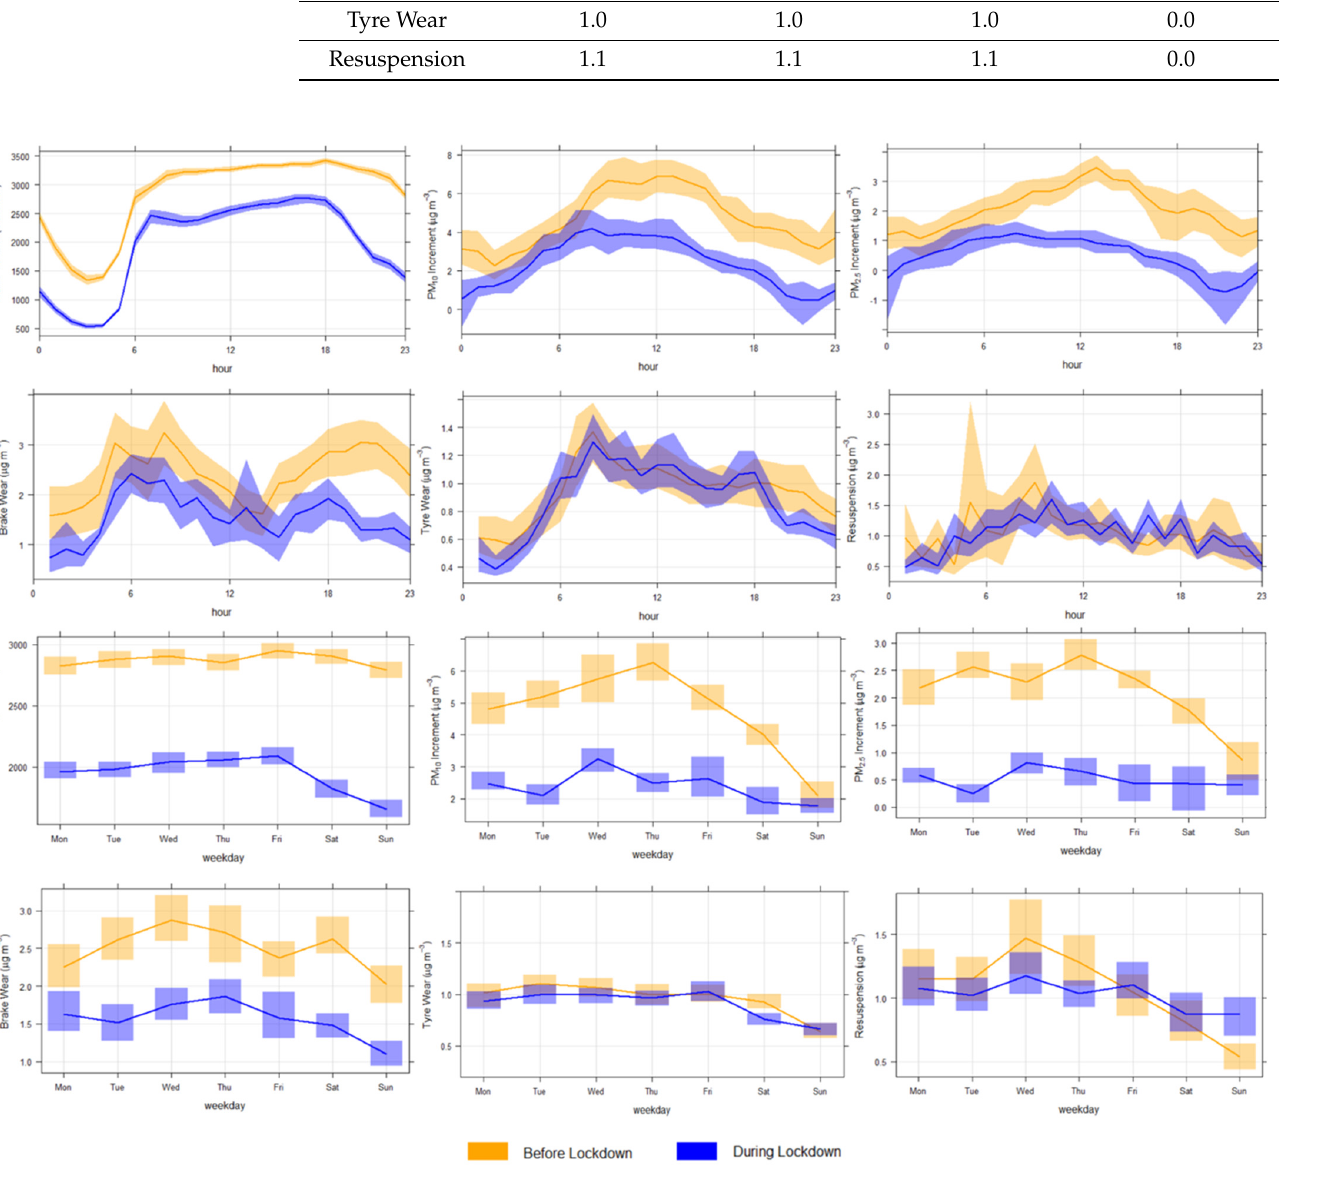
Figure 5. Diurnal and day-of-week variation of total hourly traffic volume, PM 10 traffic increment, PM 2.5 traffic increment, brake wear, tyre wear, and resuspension concentrations before and during lockdown and the 95% confidence intervals ( μ g/m 3 ).